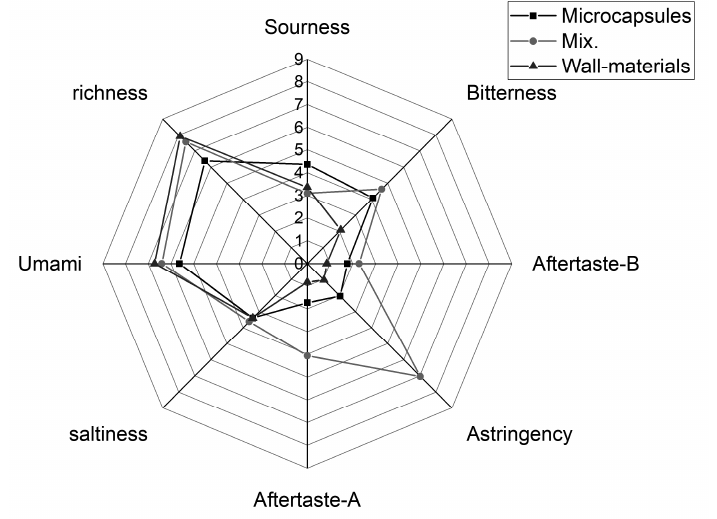
Figure 7. Radar image of electronic tongue results.